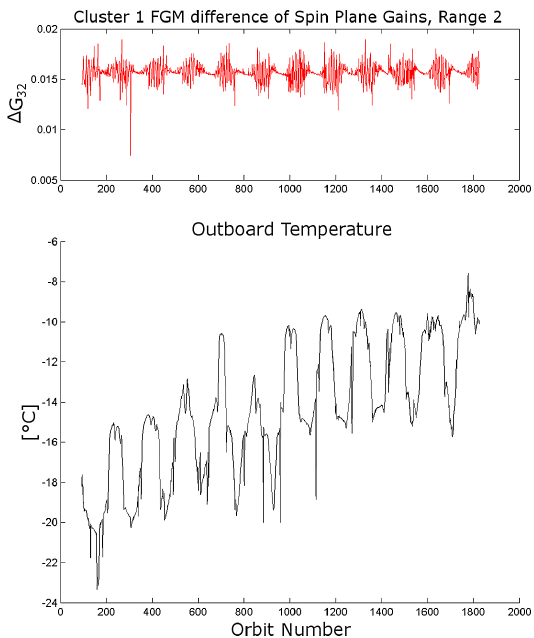
Figure 18. Spin-plane gain difference ( 1G 32 ) for C1, range 2 and sensor temperatures in degrees Celsius for orbits 93–1825 (Febru- ary 2001–February